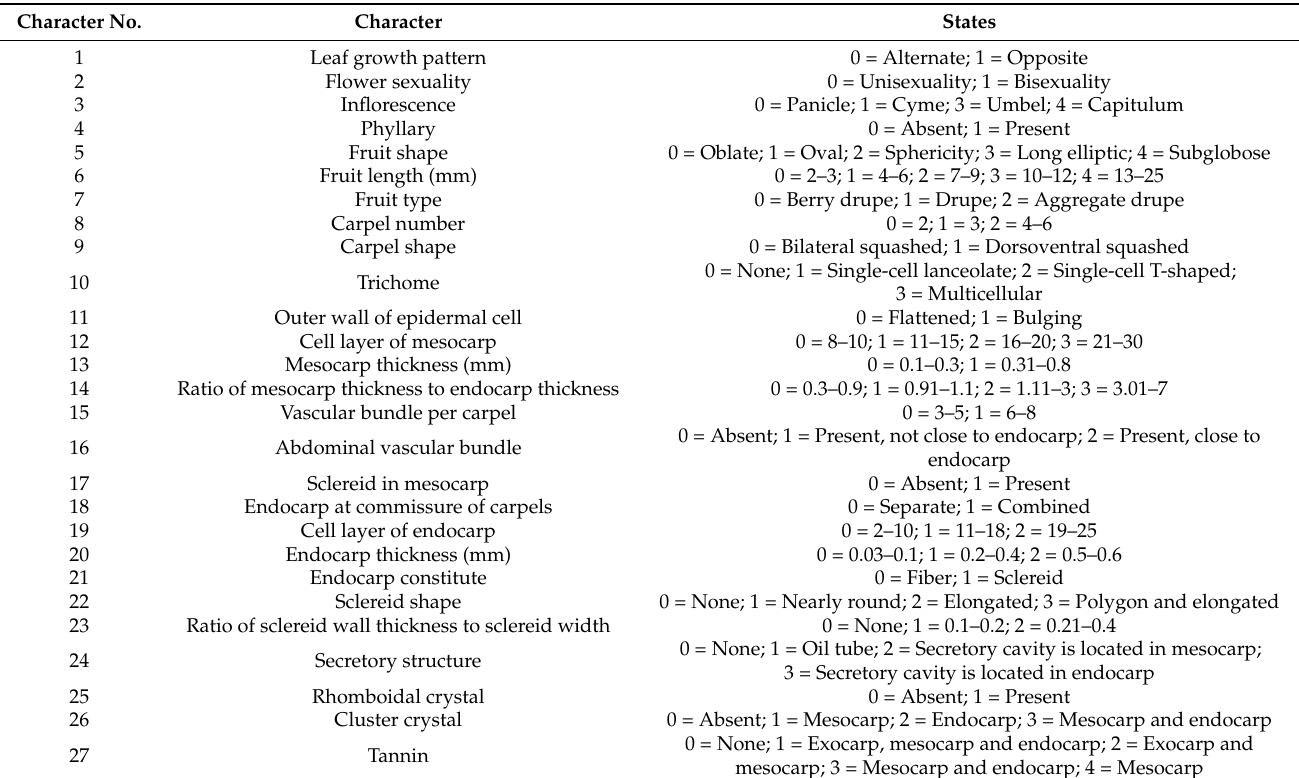
Table 2. Characters and character states used in the phylogenetic analysis of fruit anatomical and micromorphological characters in Chinese Cornaceae and related taxa.